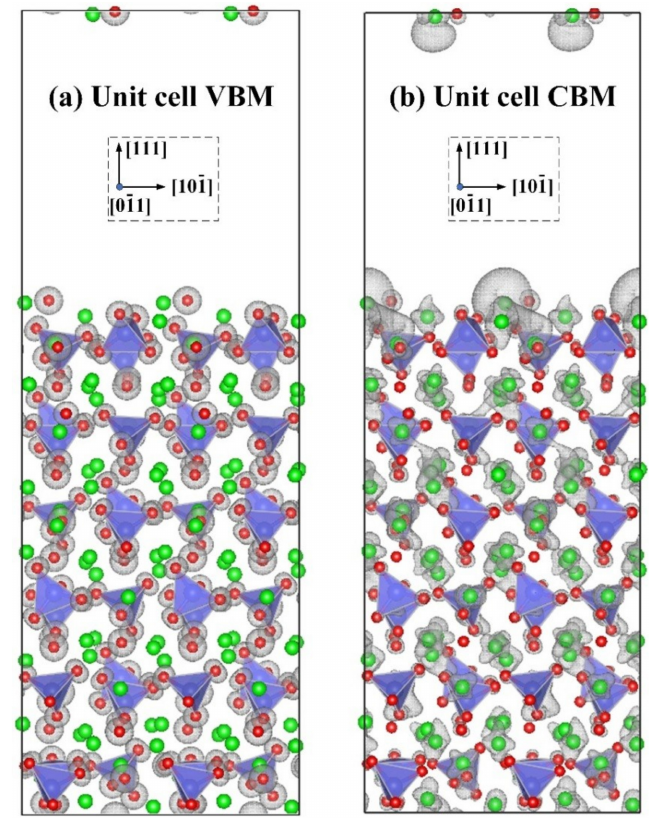
Figure A2. Band decomposed charge densities at the TVB and BCB, ρ ( r ) TVB and ρ ( r ) BCB , of M3-C 3 S slab